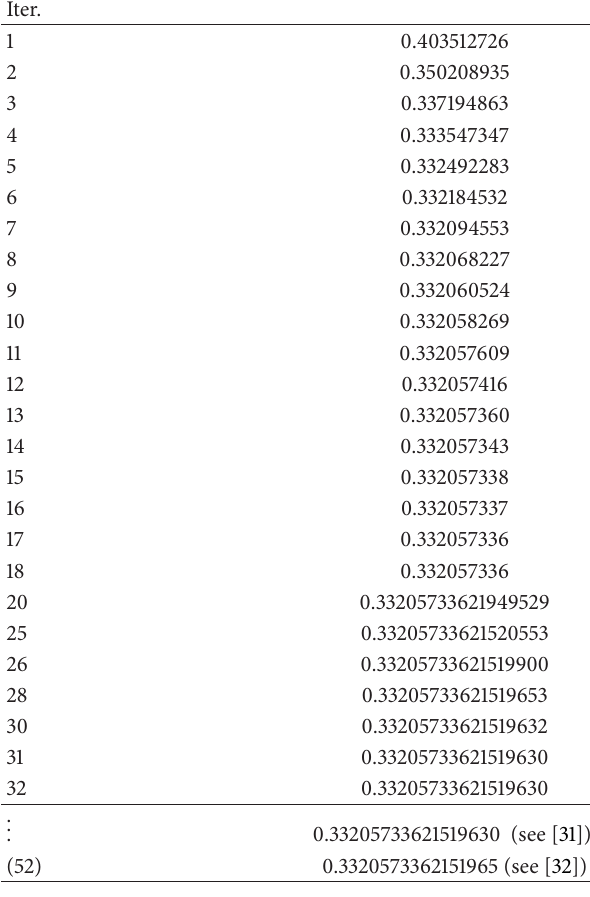
Table 3: SQLM computed results for the skin friction 𝑓 󸀠󸀠 (0) of the Blasius